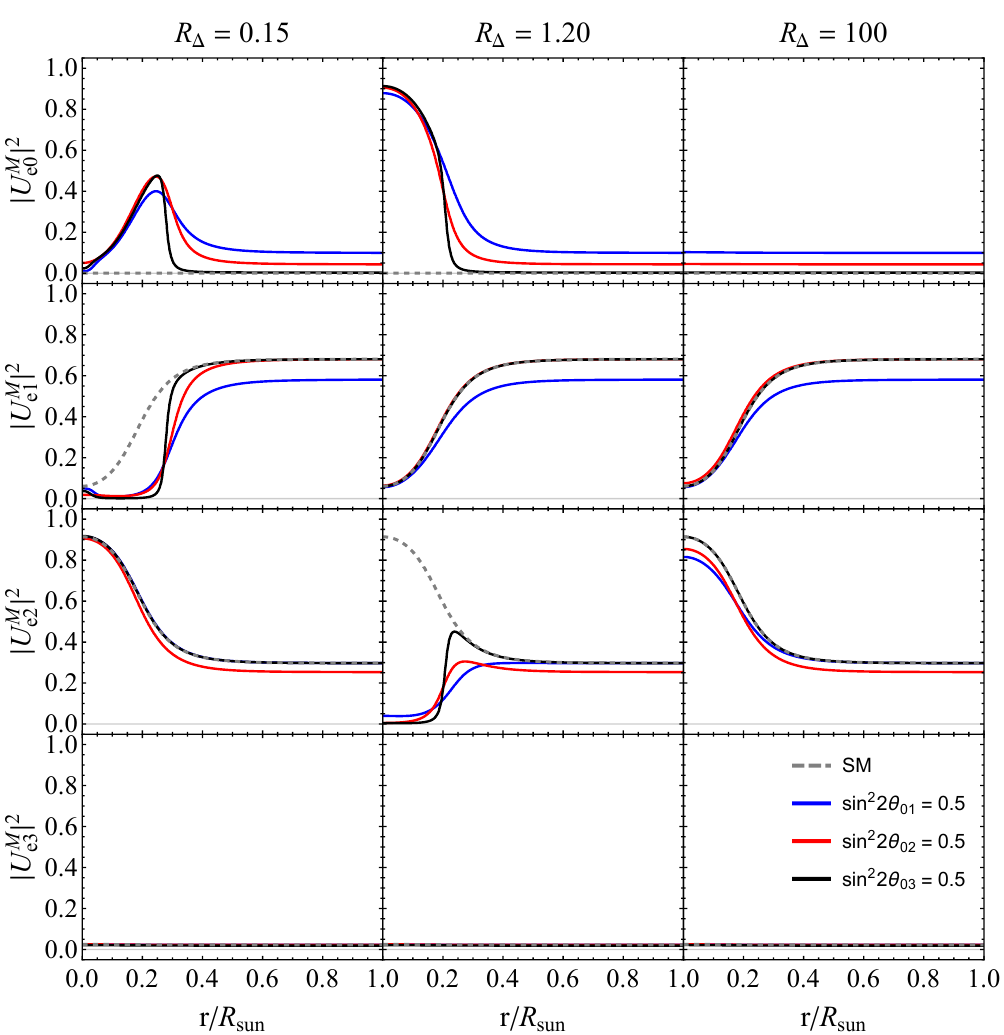
(cid:12) (cid:12) 2 as a function of the propagation distance in the Sun. The left (middle) [right] Figure 6 . (cid:12) U M ei (cid:12) panels correspond to R ∆ = 0 . 15 (1.20) [100]. The neutrino energy is fixed to be E ν = 10 MeV . Other oscillation parameters are the same as those in figure